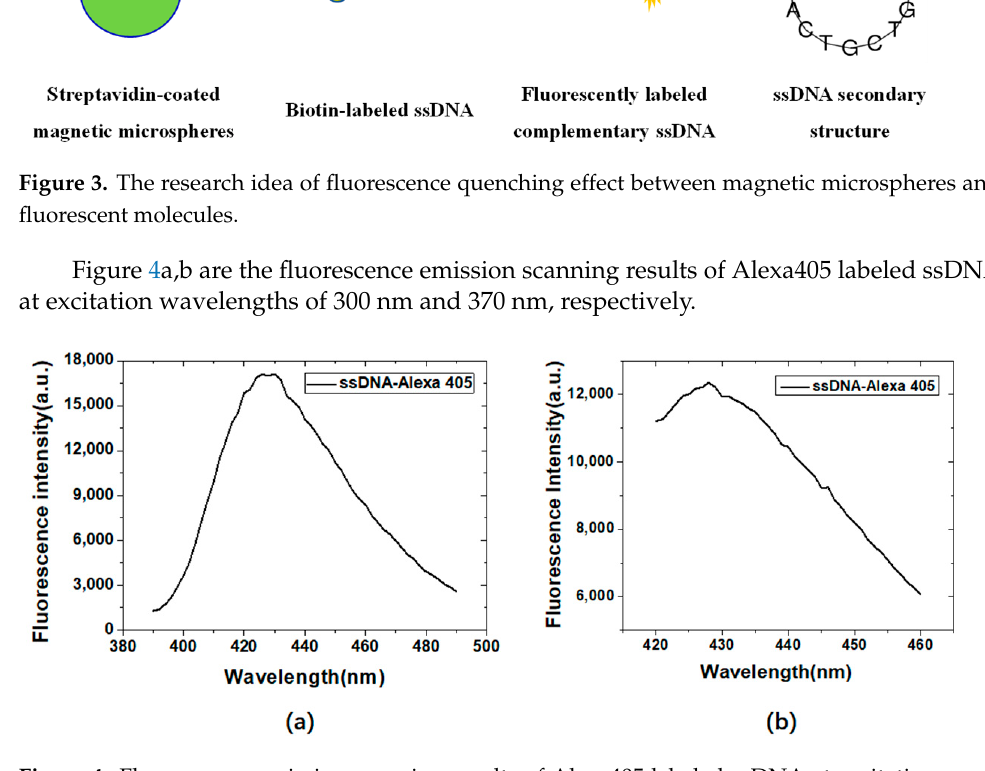
Figure 5. Fluorescence emission scanning results of ROX labeled ssDNA at excitation wavelengths of 500 nm ( a ) and 550 nm ( b ). The fluorescence measurement results of Alexa405 (a) or ROX (b) labeled ssDNA be- fore and after binding to streptavidin-coated magnetic microspheres are shown in Figure 6. Streptavidin-coated magnetic microspheres had a good fluorescence quenching effect on ROX. ROX was selected to label the abrin aptamer. Figure 6. Fluorescence measurement results of Alexa405 ( a ) or ROX ( b ) labeled ssDNA before and after binding to streptavidin-coated magnetic microspheres.